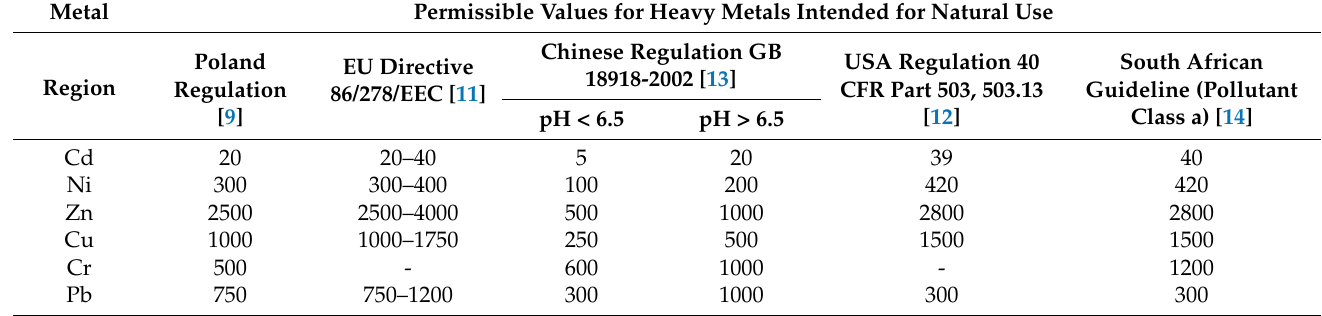
Table 1. Normative limit values of heavy metals in sewage sludge for natural use (mg/kg d.m.). Metal Permissible Values for Heavy Metals Intended for Natural Use